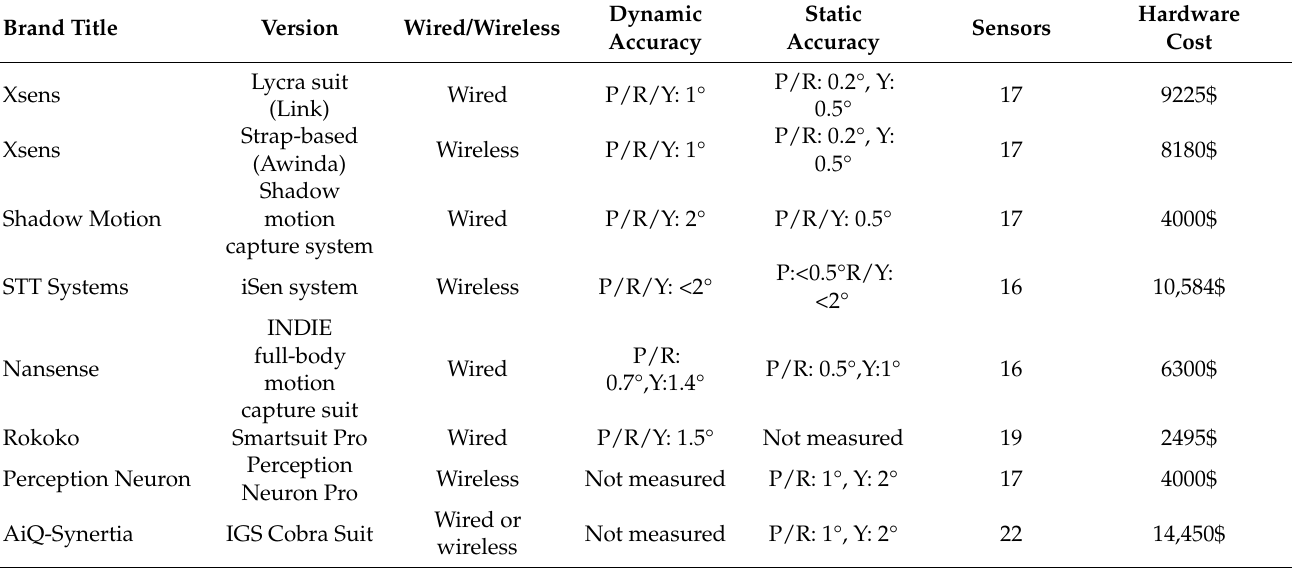
Table 2. Comercial inertial motion unit (IMU) motion-tracking suits (P-Pitch, R-Roll,